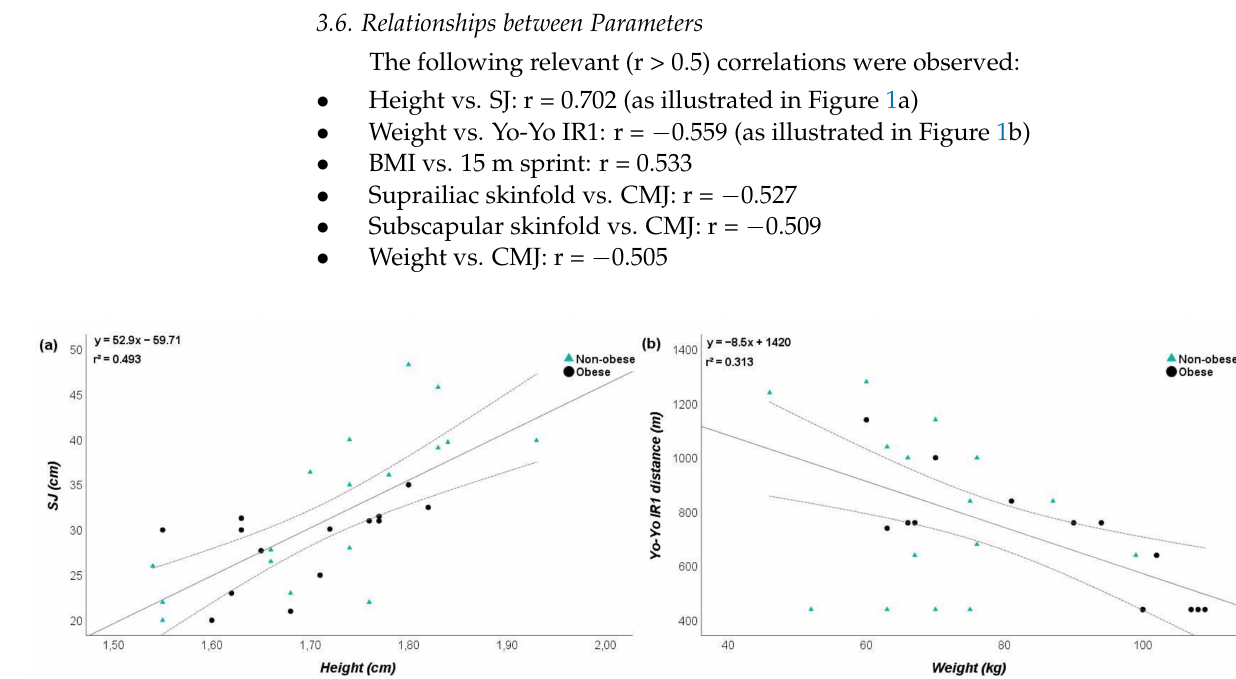
Figure 1. Relationship between ( a ) height and squat jump (SJ) and ( b ) Yo-Yo IR1 and weight. Please note that one dot can represent several subjects.